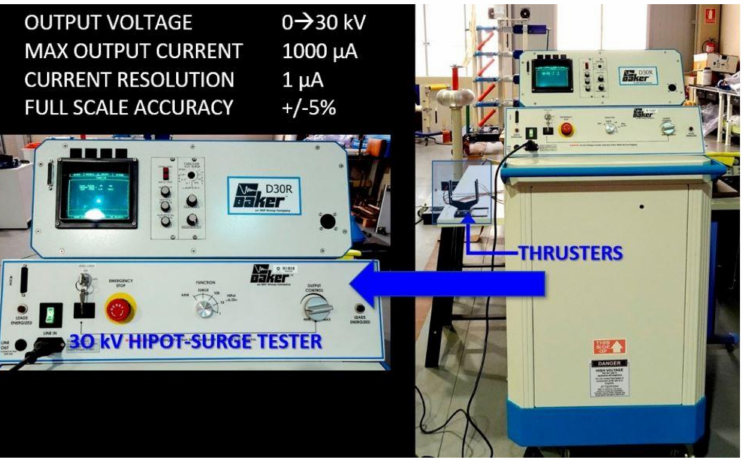
Figure 5. Baker™ D3 0 R Hipot, surge, DA and PI tester connected to the thruster during a